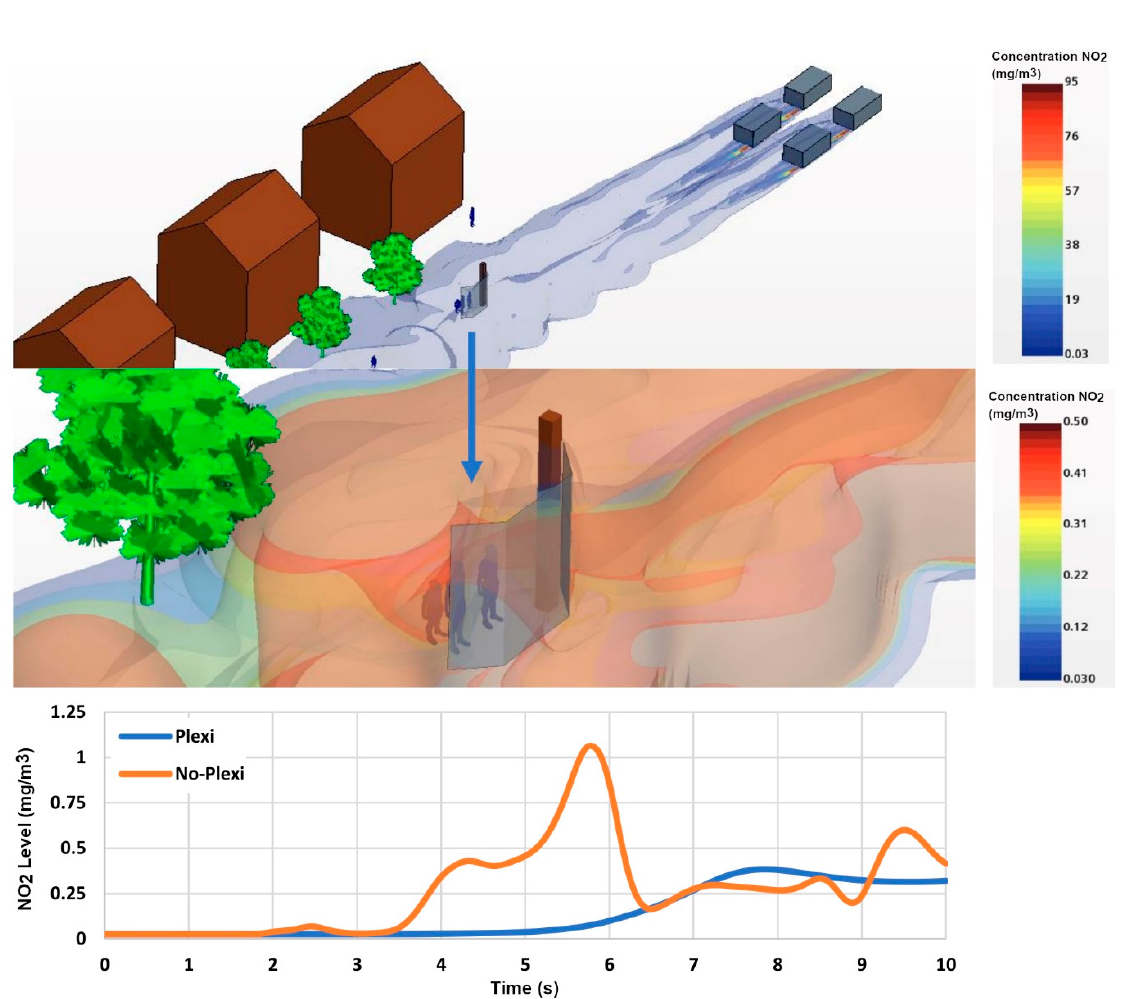
Figure 9. Exposure reduction due to the addition of a plexiglass barrier at the traffic light.